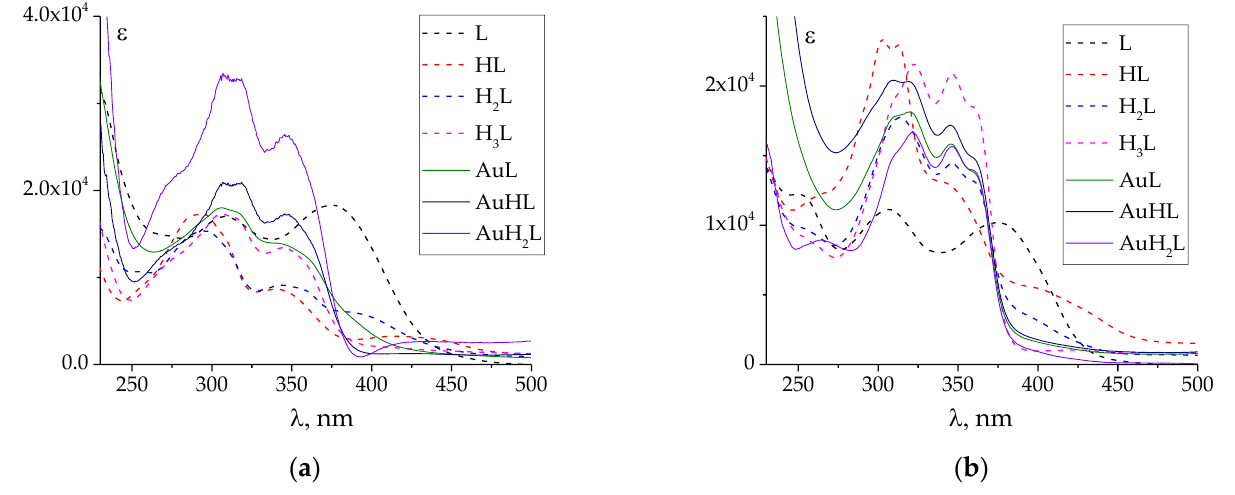
Figure 4. Calculated UV – Vis spectra of individual protonated and complex species of PLP-INH ( a ) and PLP-F2H ( b ). The spectra of protonated species are adopted from [44]. ‘Au’ denotes tetrachloroaurate(III).